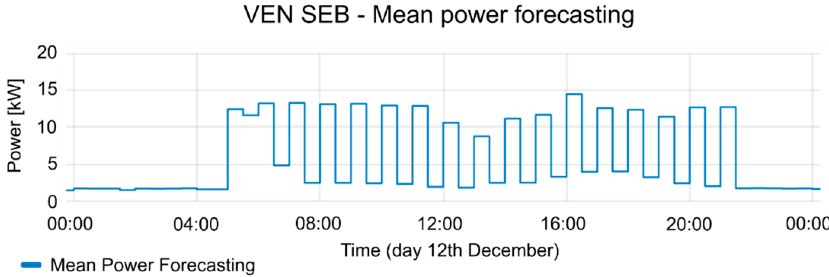
Figure 17. Consumption forecasting for 12 December test.